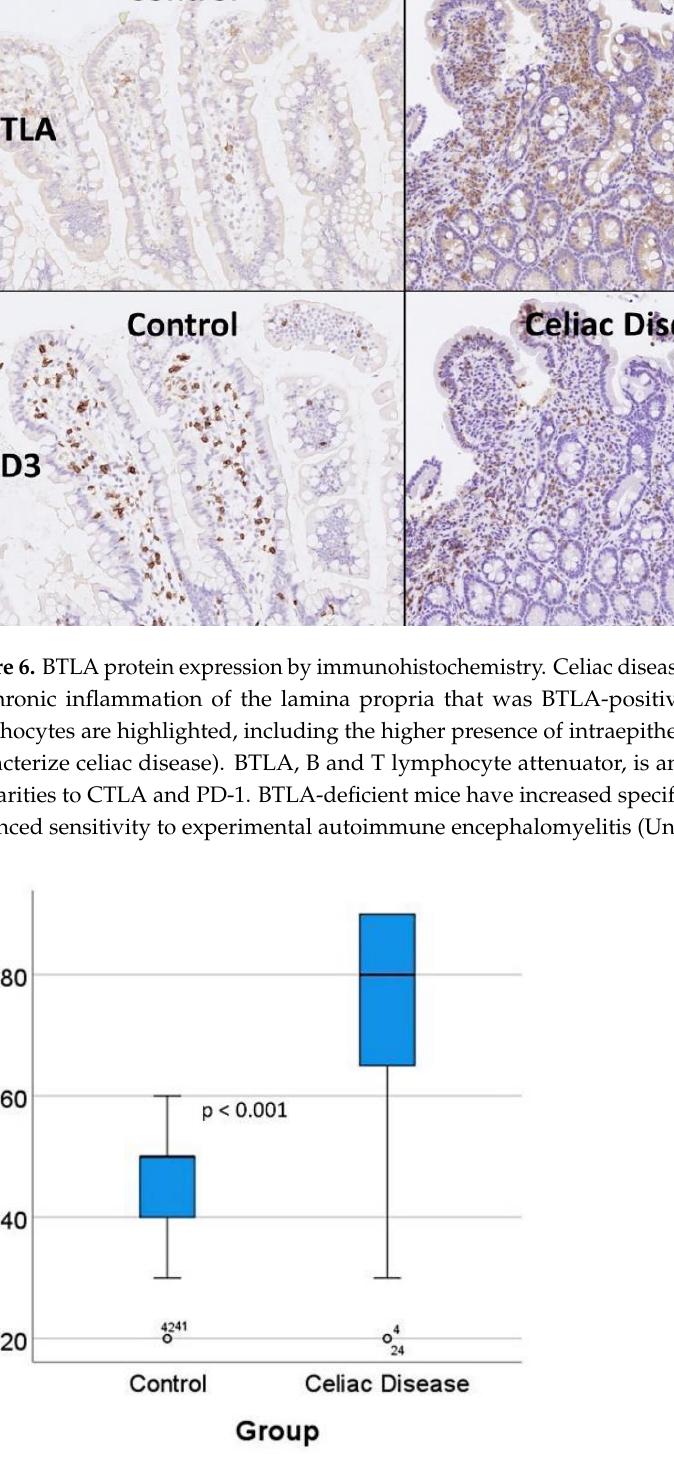
Figure 8. BTLA protein expression by immunohistochemistry in relationship with other markers. Hematoxylin & Eosin staining confirmed the histological diagnosis of celiac disease, with increased intraepithelial lymphocytes (IELs) and with villous atrophy. The IELs were CD3+, CD4 − , CD8+ and CD56 − . Scarce FOXP3+regulatory T lymphocytes (Tregs) could be identified in the lamina propria. PD-1 staining was negative. The staining with BTLA was high in the lamina propria, and had a pattern of B lymphocytes. BTLA, B and T lymphocyte attenuator, is an inhibitory receptor with sim- ilarities to CTLA and PD-1. BTLA-deficient mice have increased specific antibody responses and enhanced sensitivity to experimental autoimmune encephalomyelitis (Uniprot).